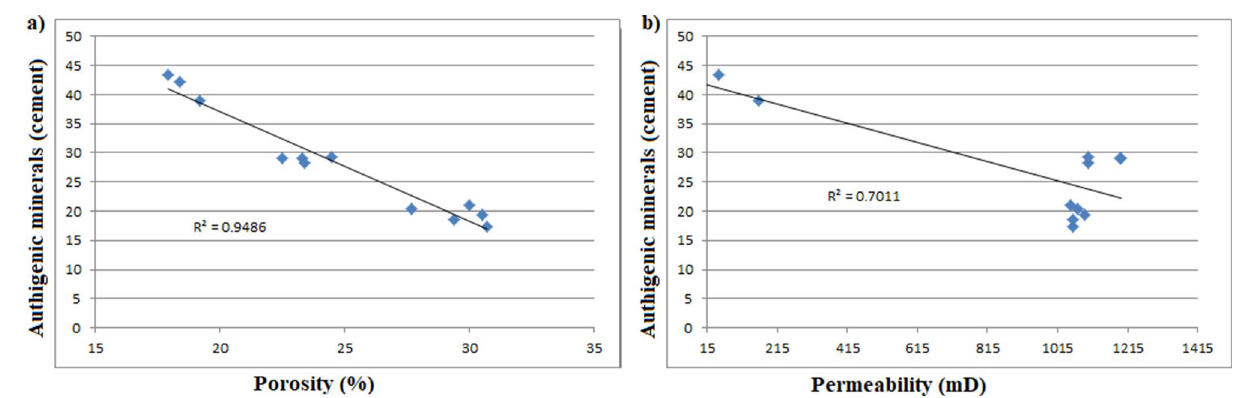
Figure 18. Cross-plots illustrating a good inverse correlation between authigenic mineral cements (including clay matrix) and porosity and permeability. This indicates that the cements are the major concern for the reservoir quality